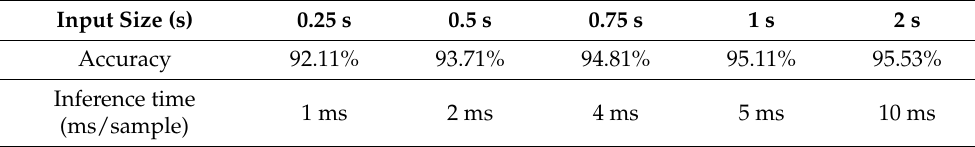
Table 7. Performances of THD-RawNet with different input